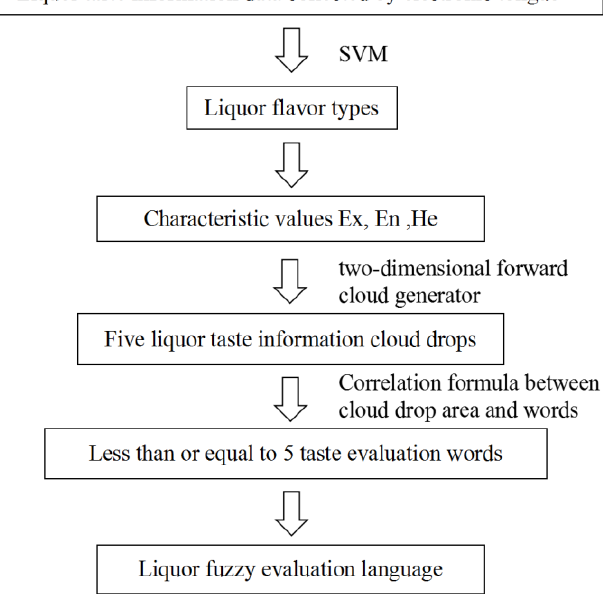
Figure A2. Flow chart of fuzzy evaluation of liquor flavor.